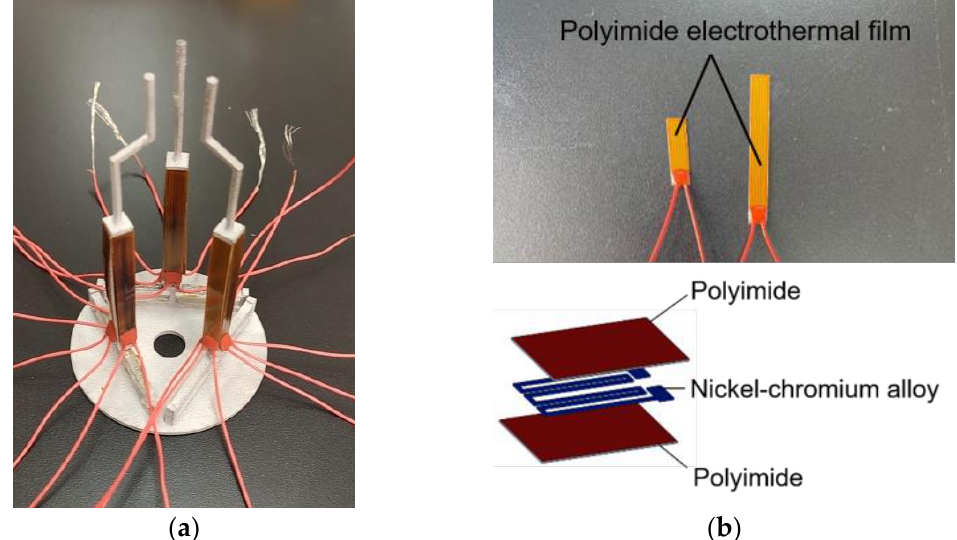
Figure 4. The fabricated 3D microgripper with the polyimide film. ( a ) The fabricated 3D microgripper; ( b ) The polyimide electrothermal film.